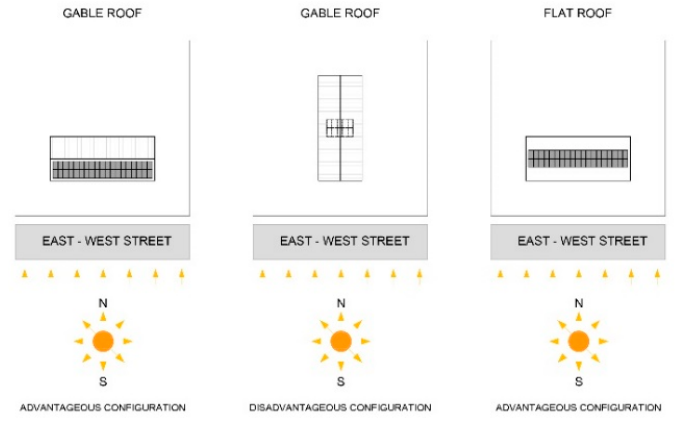
Figure 2. Possible positions of photovoltaic (PV) panels as a function of a W–E street orientation (diagram by W. Celadyn, P. Filipek).